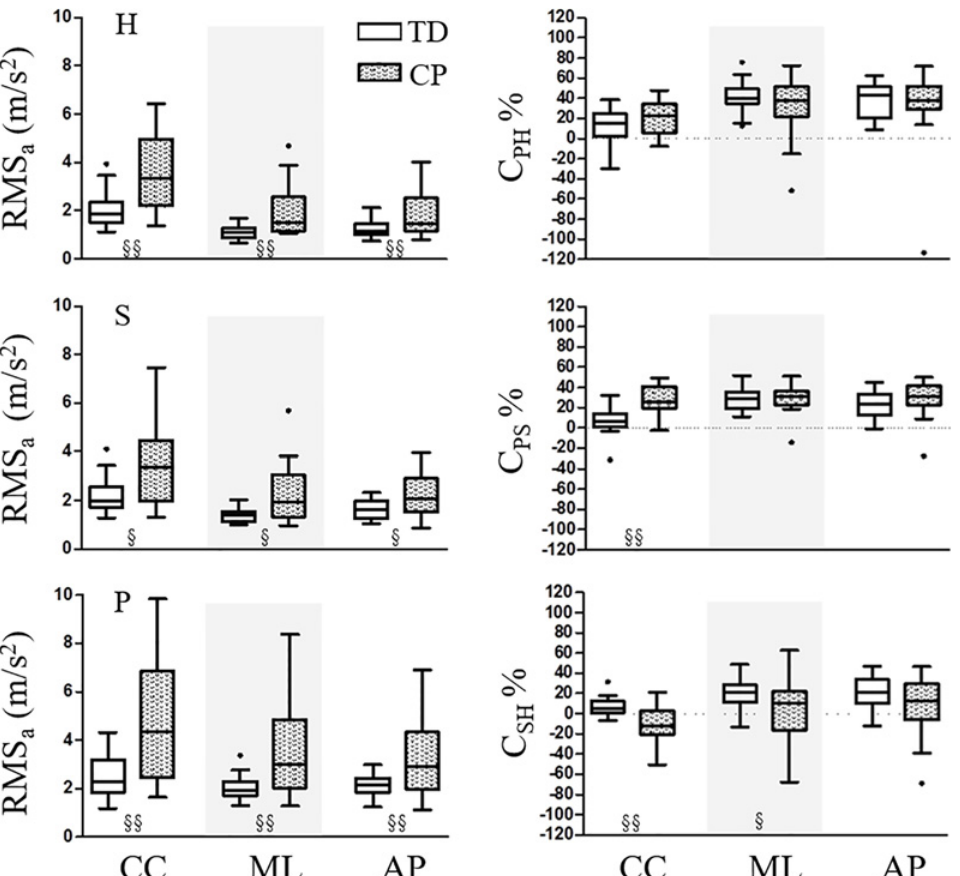
Fig 2. On the left, RMS of the acceleration components at the three levels. On the right, attenuation coefficients from pelvis to head (C PH ), from pelvis to sternum (C PS ), and from sternum to head (C SH ) along the three anatomical axes. Parameters computed for the TD and CP groups are represented with empty and filled box-plots, respectively. Significant between-groups differences (p < 0.05 or p < 0.01) are reported with the symbol § or §§,